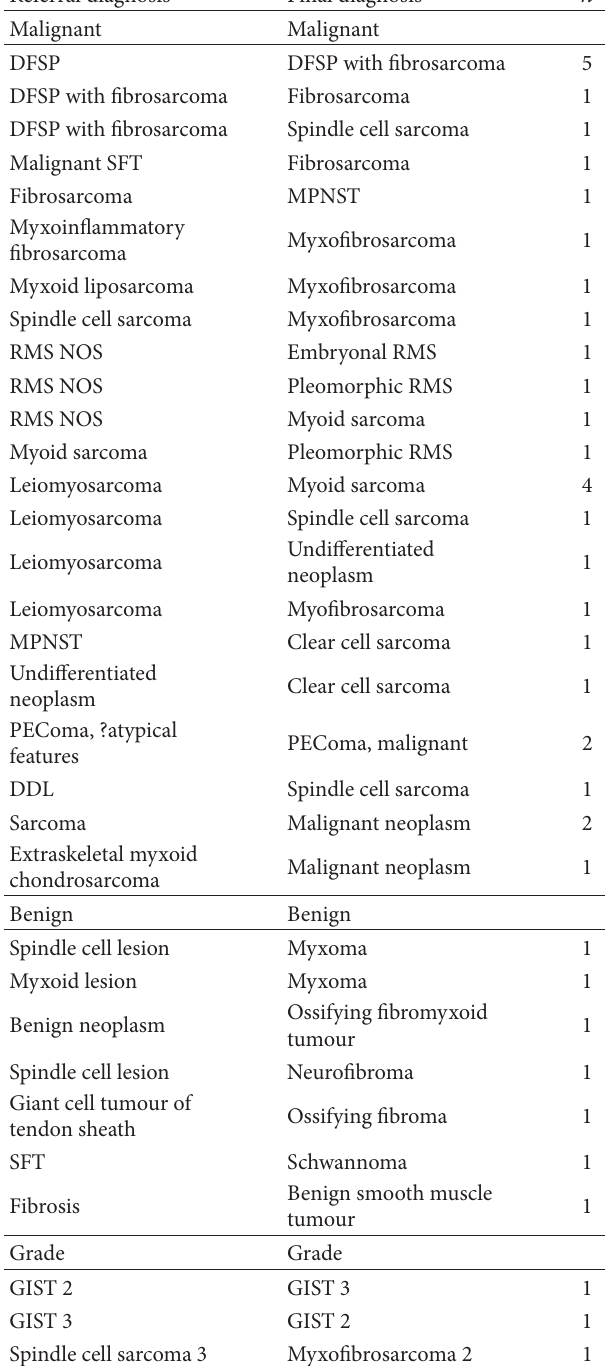
Table 2: Summary of cases showing minor